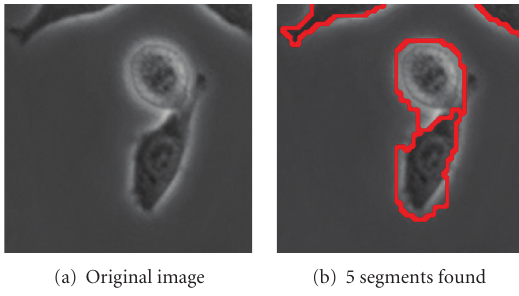
Figure 10: Parameters used: (b) n = 60, α = 190, (cid:7) α = 5, β = 100, θ = 0 . 09, γ = 0 . 35, d 1 = 0 . 15, σ = 6, ρ = 3.